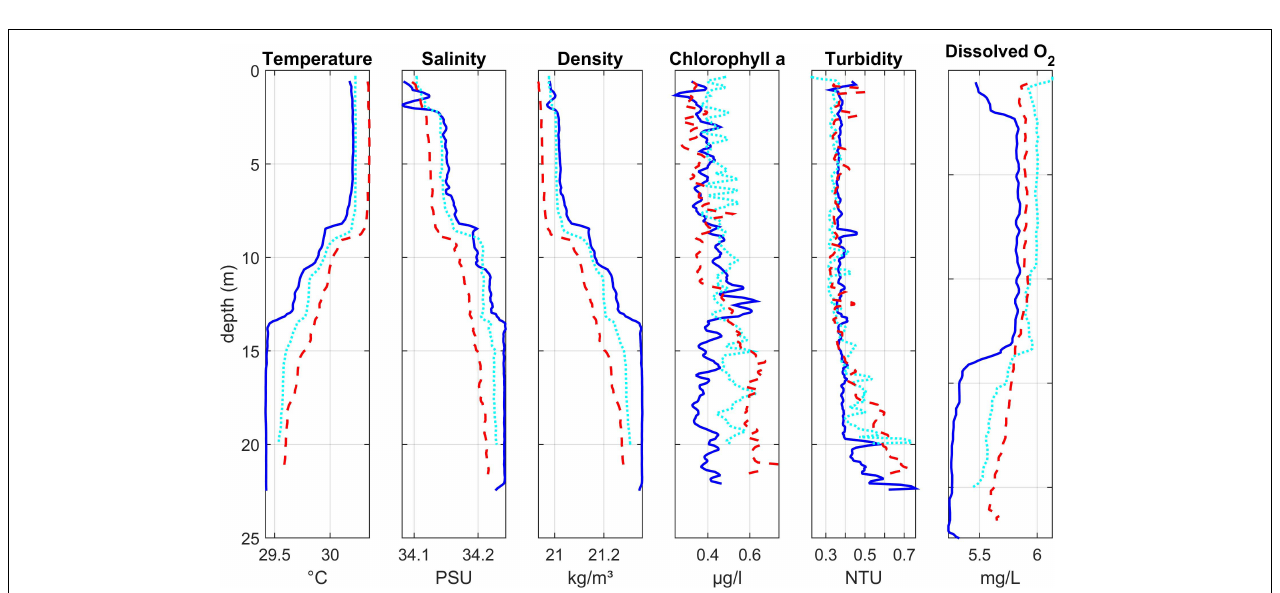
FIGURE 3 | Depth profiles of water column properties at three lagoon stations close to the lagoon mouth (Region 3): Lagoon_07 (dark blue solid line) closest to the open ocean, Lagoon_06 (light blue dotted line), and Lagoon_02 (red dashed line) furthest into the lagoon. See Figure 1 for station locations.